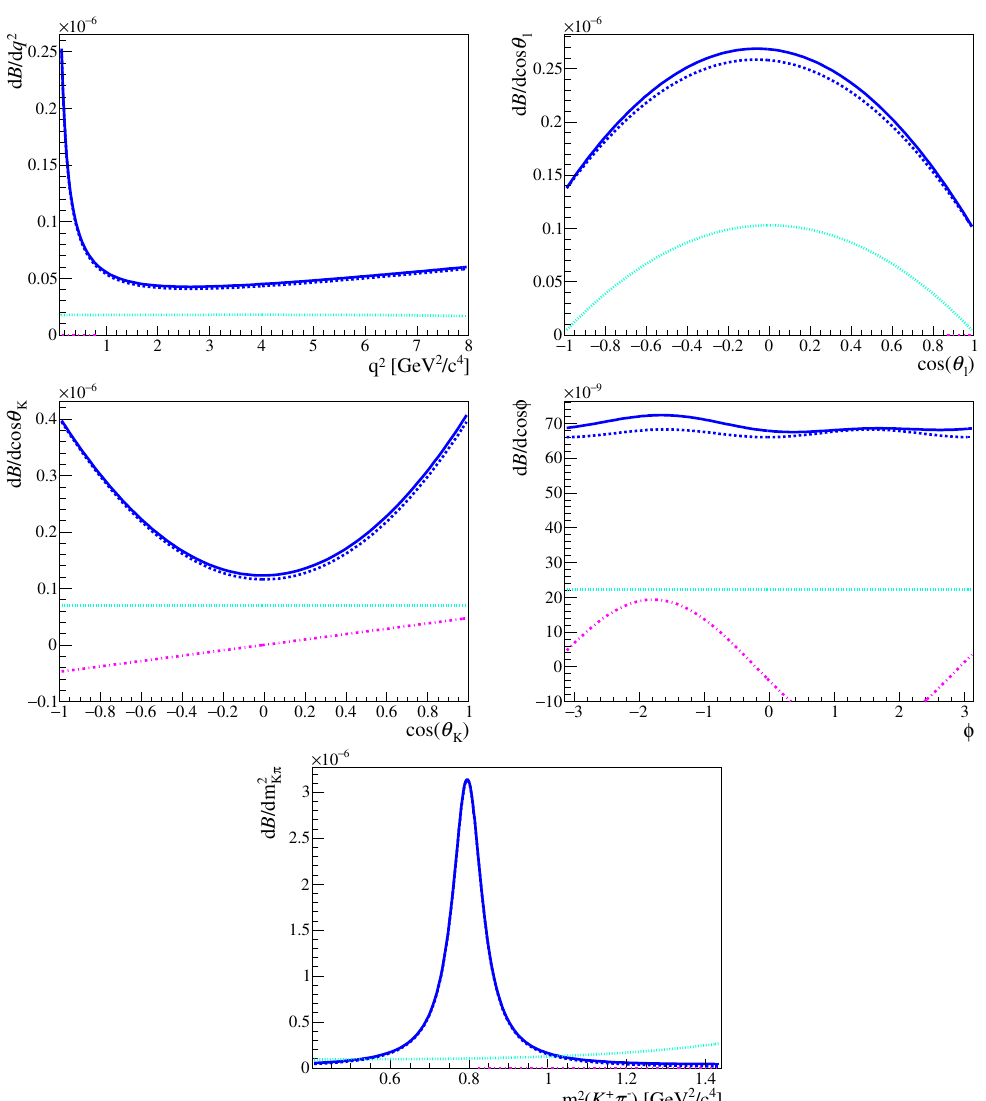
Figure 2. Di(cid:11)erential B 0 ! K (cid:3) 0 (cid:22) + (cid:22) (cid:0) branching fraction depending on q 2 , the three decay angles cos (cid:18) l , cos (cid:18) K and (cid:30) and m 2 in the q 2 range 0 : 1 < q 2 < 8 : 0 GeV 2 =c 4 . The blue solid line denotes K(cid:25) the full P+S-wave prediction, the blue dashed line the P-wave component, the teal dotted line the S-wave component and the magenta dash-dotted line the P-wave/S-wave interference. Both the S-wave component and the interference are scaled by a factor 10 to improve